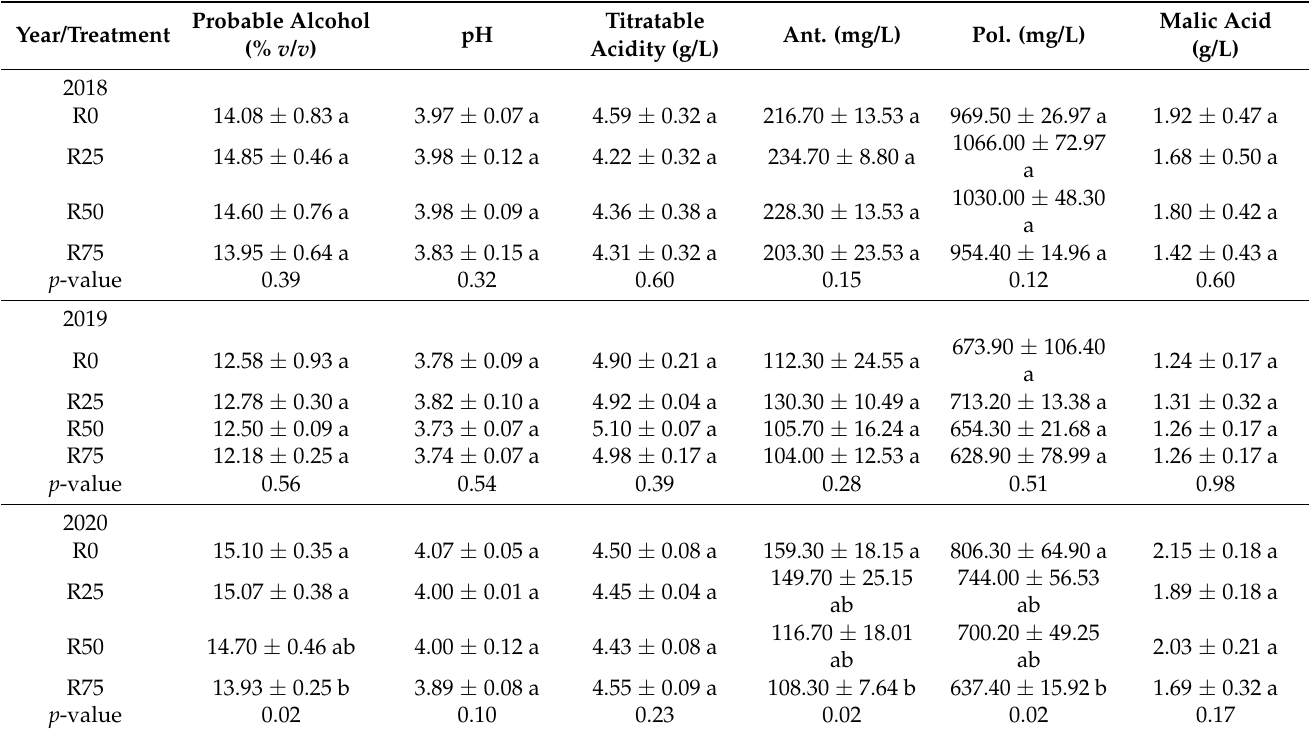
Table 3. Influence of rainfed and irrigated vines in grape composition during each season. Ant.—anthocyanin content; Pol.—polyphenol content. Values are represented as mean ± standard deviation. In each column, values with different letters show a statistical significance at p < 0.05 by Tukey HSD